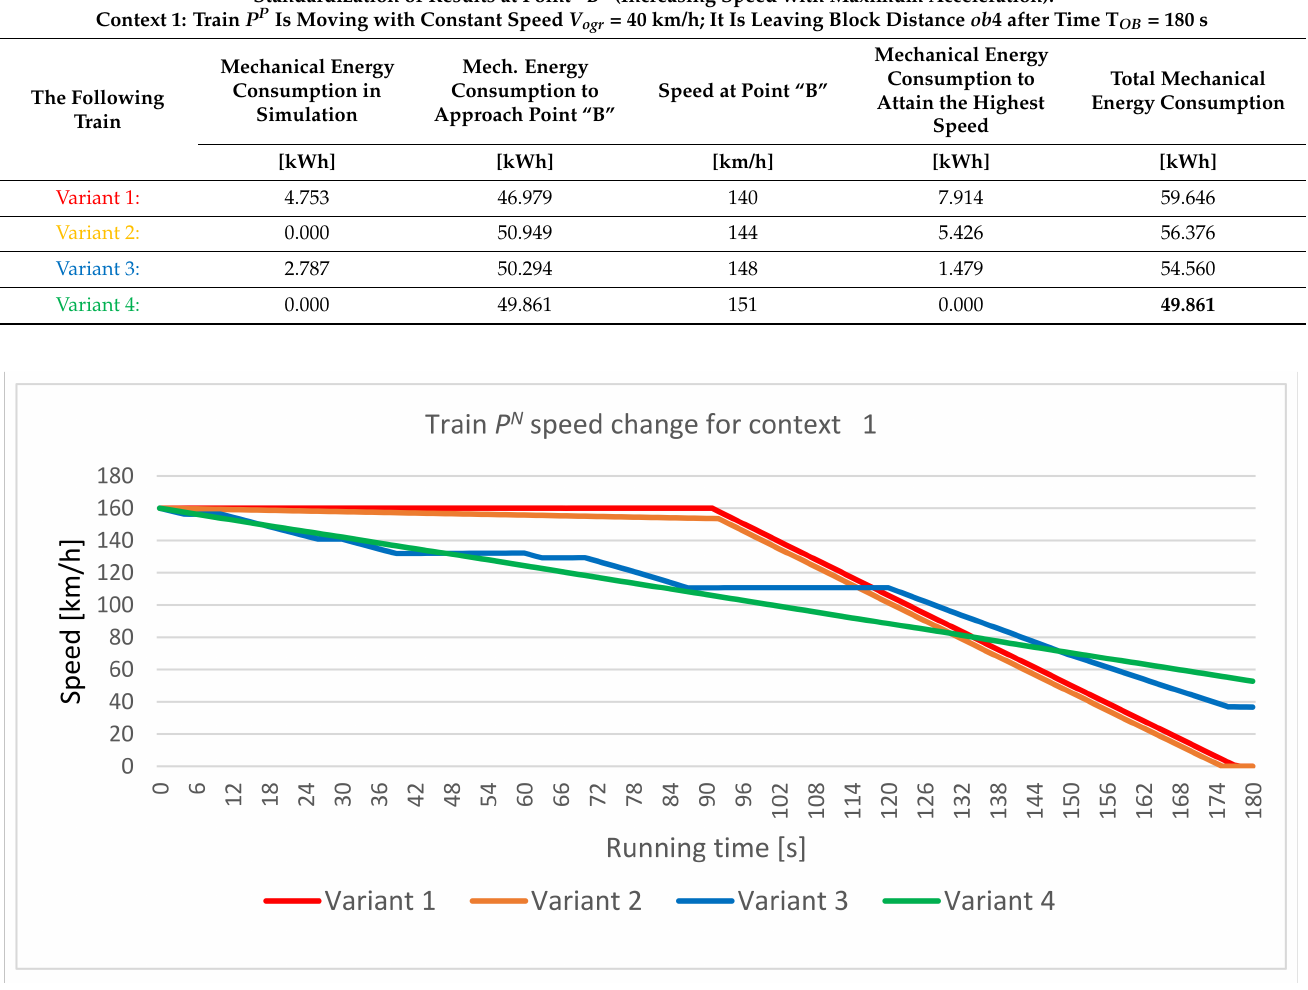
Figure 8. Distance made by the P N train for different movement variants; context 1 (source: own